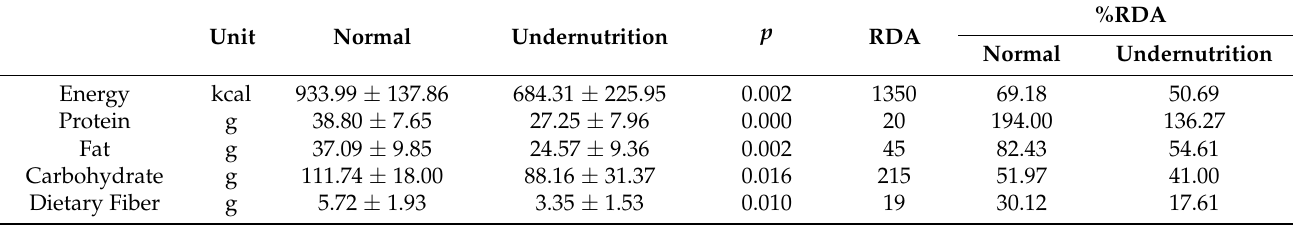
Table 2. Daily dietary intake between the two groups.